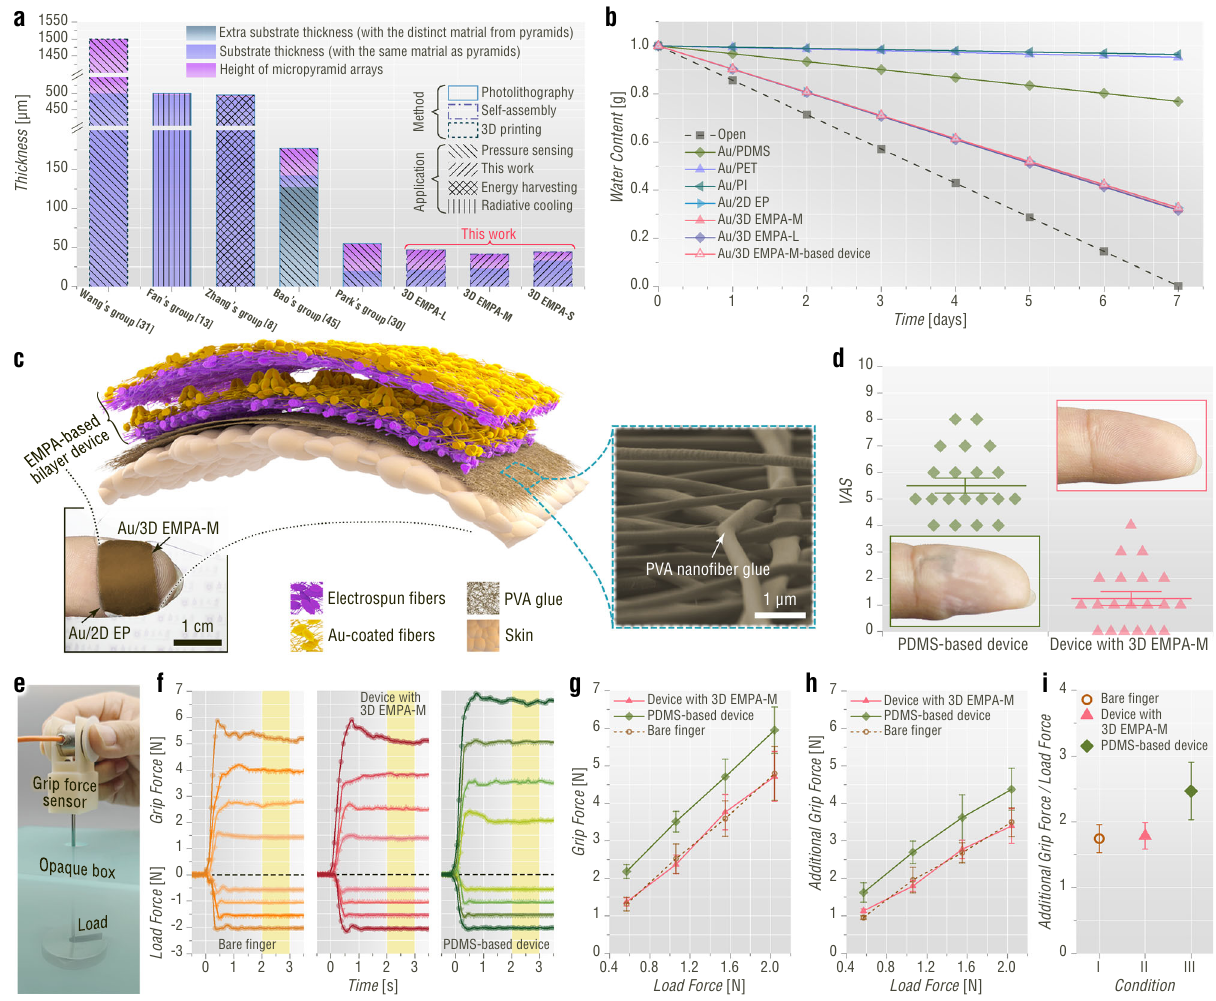
Fig. 3 | Imperceptibilityevaluations ofEMPA-based on-skin devices.a Plotfor a comparative study of micropyramid-array-based fl exible devices in terms of thickness. b Watervaportransmissiontestsofthreedifferenttypesofconventional on-skin fi lmmaterialsandEMPA-basedon-skindevices. c Schematicdiagramofthe EMPA-based bilayer on-skin device. The inset shows an SEM image of the on-skin electrospun PVA nano fi ber glue. d Participants reported any feelings while two typesofdeviceswereattachedtothe fi ngertip,whichwasevaluatedbasedonaVAS (0 – 10). Crosses indicate the mean, and error bars are the standard error of the mean. The insets in the green and pink boxes show fi ngertip skin after being